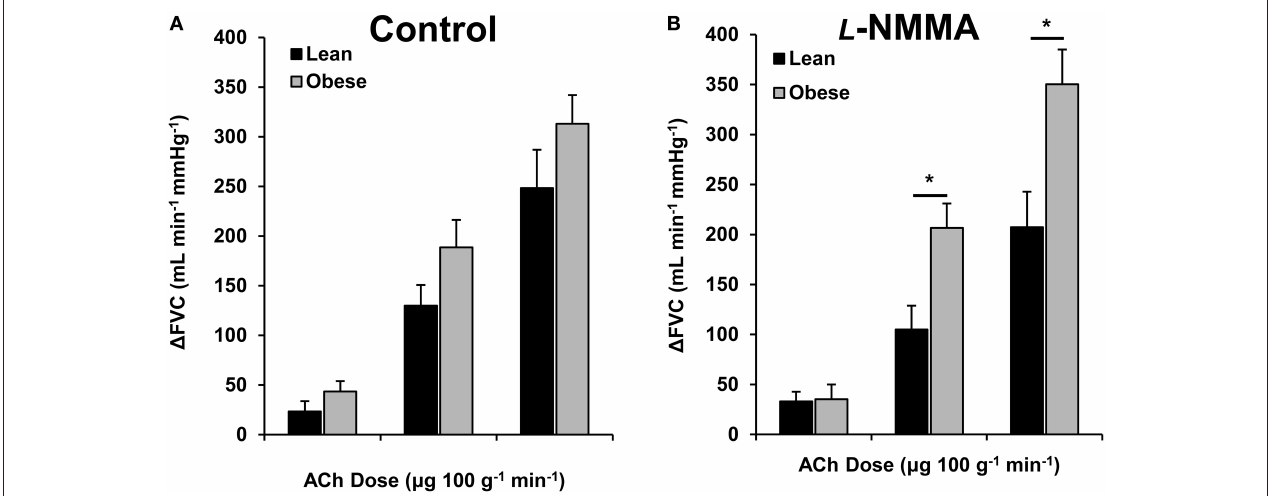
FIGURE 2 | ACh responses with l-NMMA. Change in forearm vascular conductance ( (cid:2) FVC) with intra-arterial ACh infusion and NOS inhibition ( L -NMMA). (A) (cid:2) FVC without inhibition was not different between lean ( n = 18 ) and obese ( n = 21 ) adults. (B) (cid:2) FVC with L -NMMA was greater in obese adults ( n = 21 ) than lean